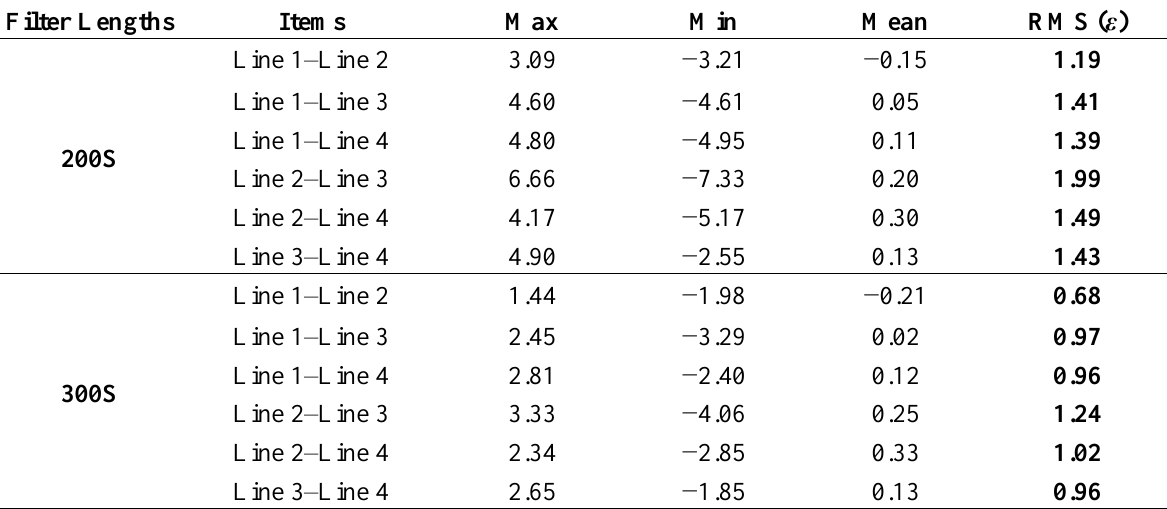
Table 4. Pairwise internal accuracy comparing between four measure lines (Units: mGal).